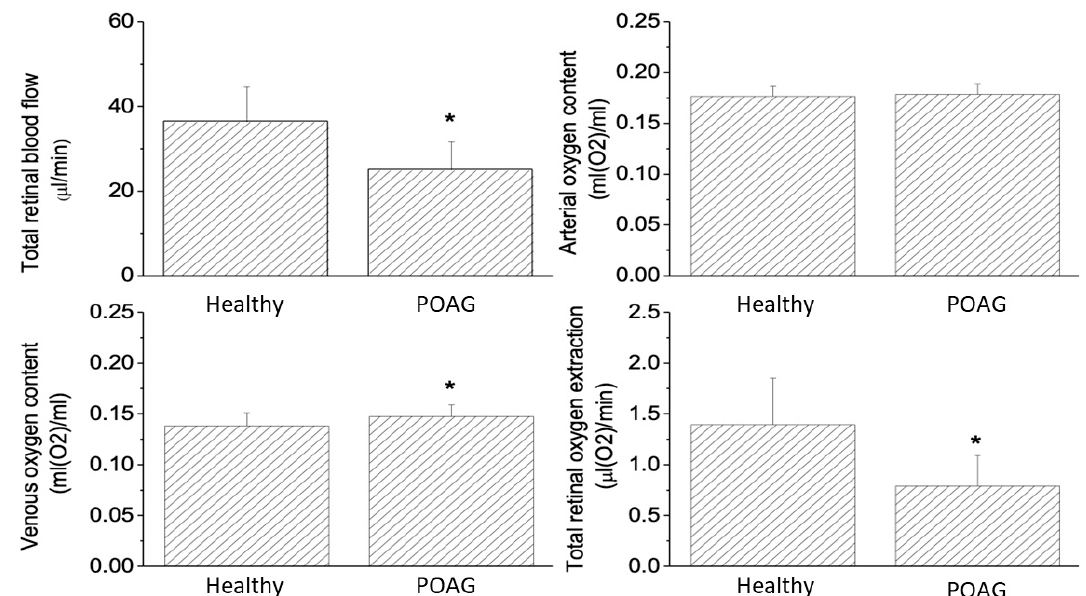
Figure 1. Retinal hemodynamic parameters in healthy control subjects and patients with POAG. Data are presented as means ± SD. * significant difference between the two groups.